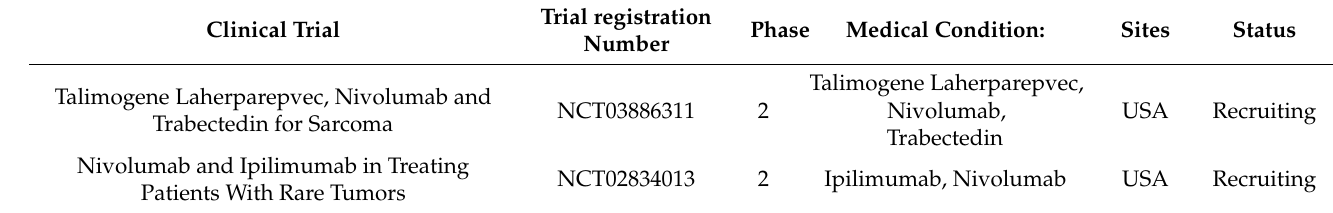
Table 5. Clinical trials programs of chordomas in